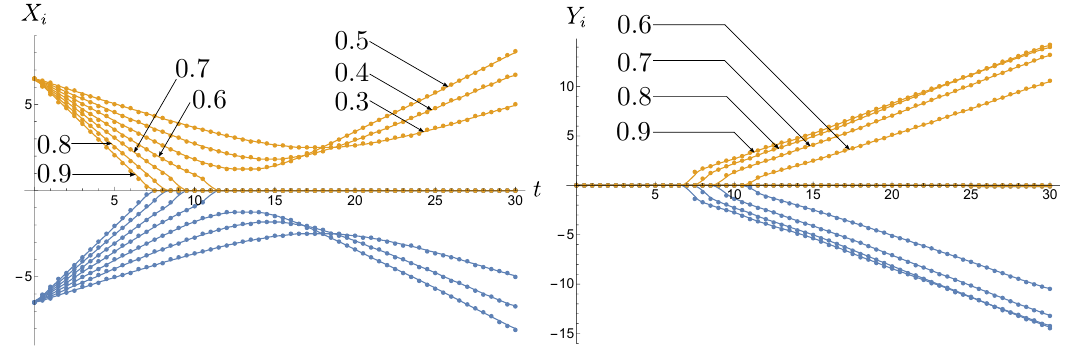
Figure 20 . Trajectories X i ( t ) and Y i ( t ) of two parallel non-Abelian vortices of type II colliding head-on with initial velocities u = 0 . 3 , 0 . 4 , · · · , 0 . 9 (marked on the plots for